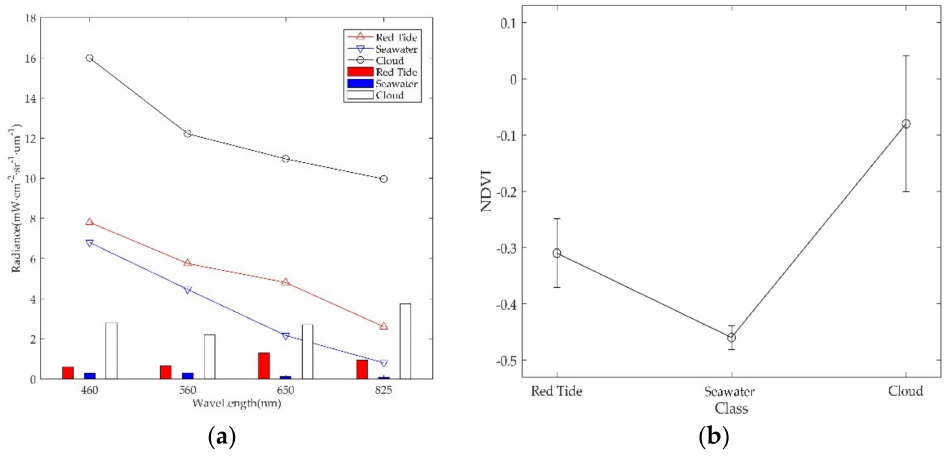
Figure 6. Statistical results of different objects. ( a ) Radiance spectral curves and their standard deviation; ( b ) NDVI